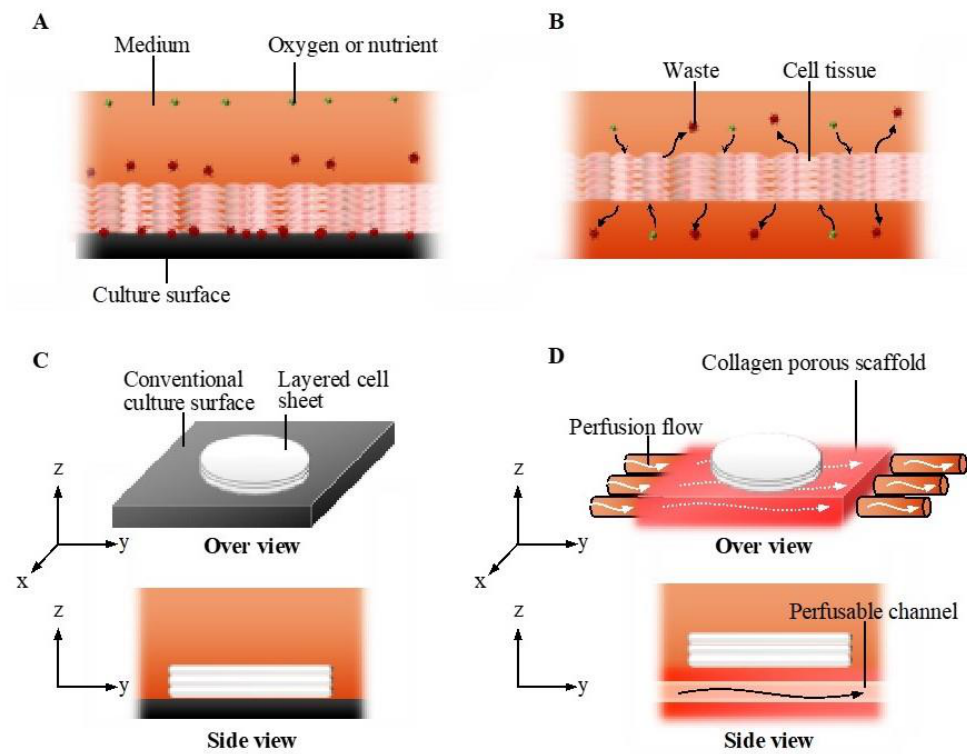
Figure 1. The concept of the perfusion system. Comparison of conventional culture ( A ) and the ideal culture ( B ) environment. Schematic images of the conventional culture method ( C ) and the culture method realized in this study ( D ).